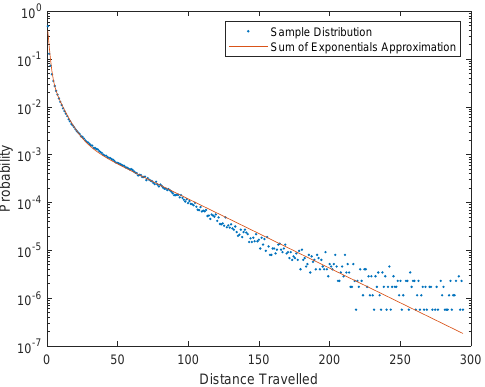
Figure 7. The distribution of Euclidean distances between targets in neighboring frames (blue dots) is approximated using a weighted sum of exponential distributions (solid orange